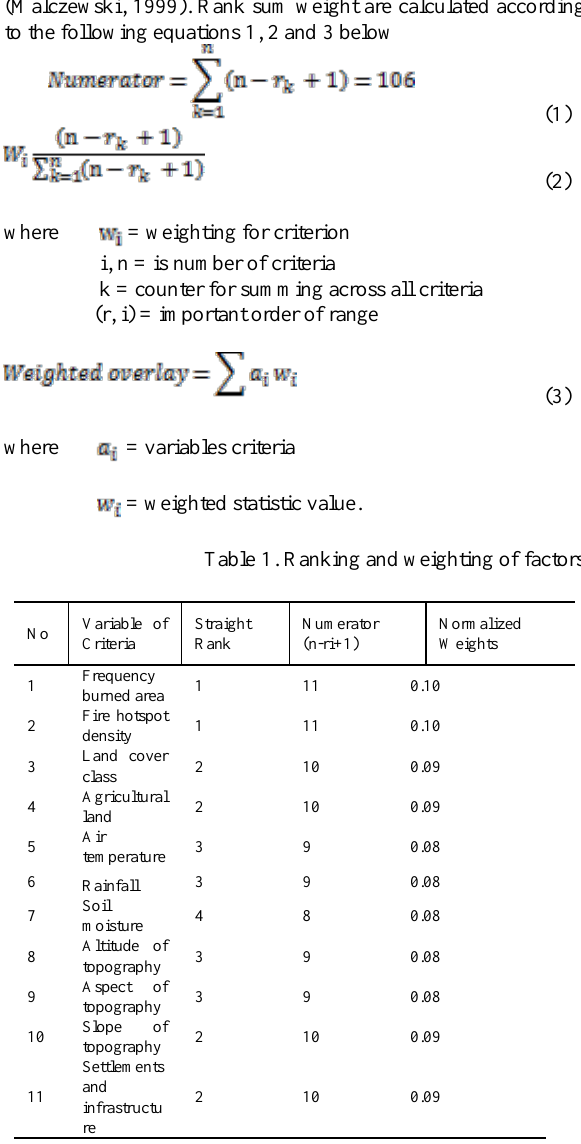
Figure 3. Causes of Wildfire behaviors.